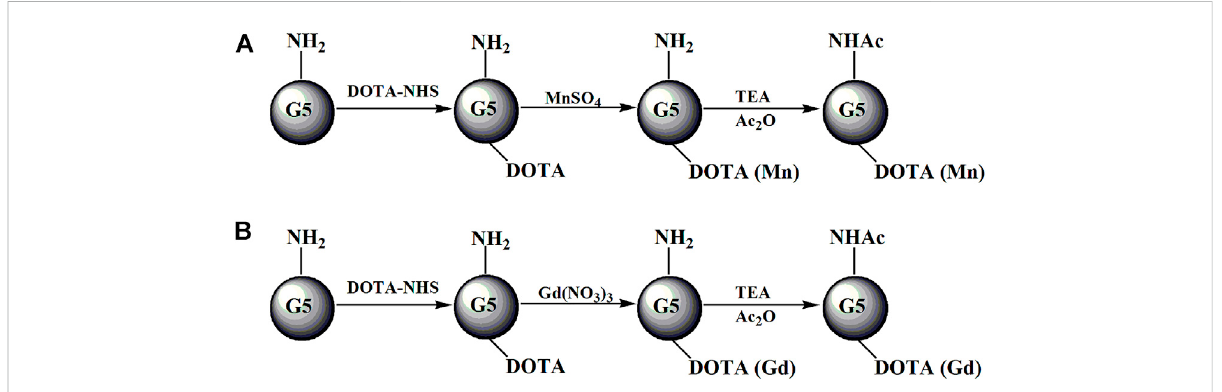
FIGURE 1 Schematic illustration of the preparation of G5.NHAc-DOTA n (Gd) (A) or G5.NHAc-DOTA n (Mn) (B) . TEA and Ac 2 O represent triethylamine and acetic anhydride, respectively.